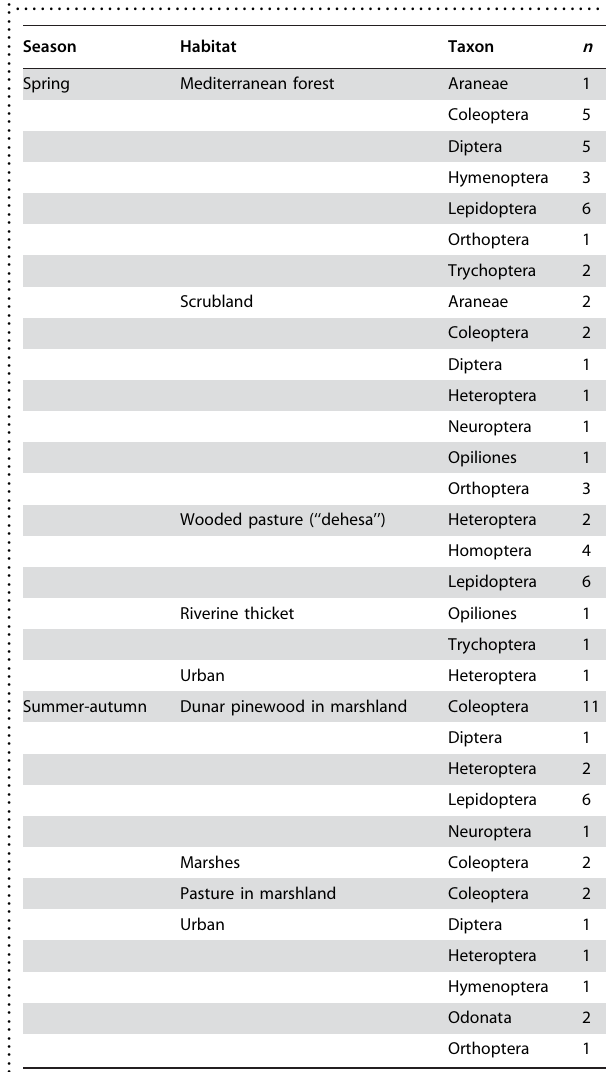
Table 2. Invertebrate samples analysed to predict